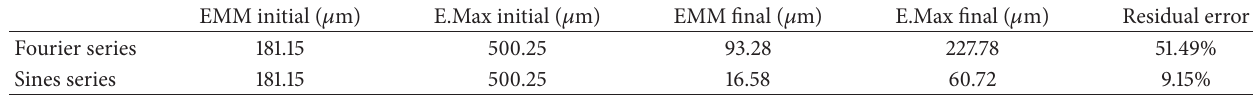
Figure 15: Comparison between generation functions and approximation functions obtained. Table 5: Fourier series versus sines series.